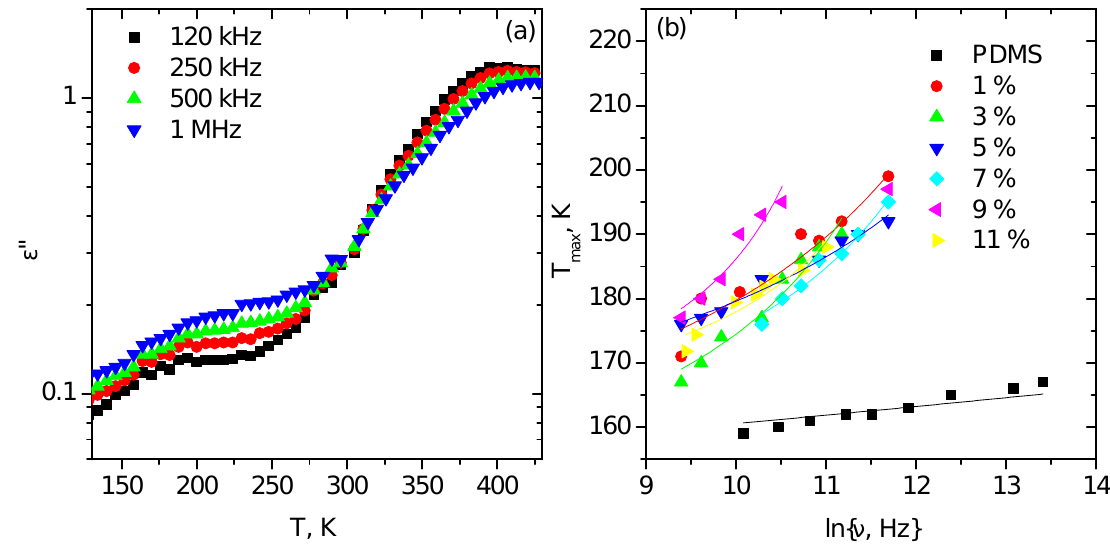
Figure 4. Typical temperature dependence of dielectric losses at different frequencies—here, 5 vol % Ni@C/PDMS ( a ). Measured frequencies versus T max for composites with different concentrations of Ni@C at lower temperatures ( b ). Table 1. Glass transition temperature, Vogel–Fulcher, and activation energies of Ni@C/PDMS